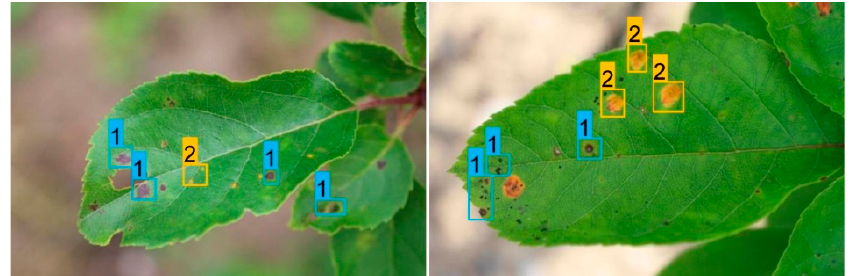
Figure 14. Plant disease detection, YOLO4: 1—apple scab ( left ) and 2—rust ( right ) [50].